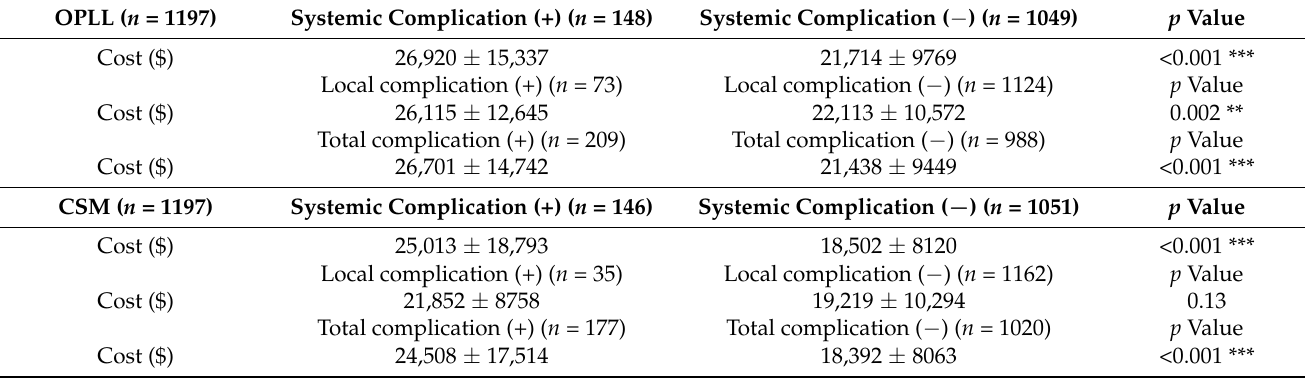
Table 5. Cost between complication (+) and ( − ) in OPLL and CSM after